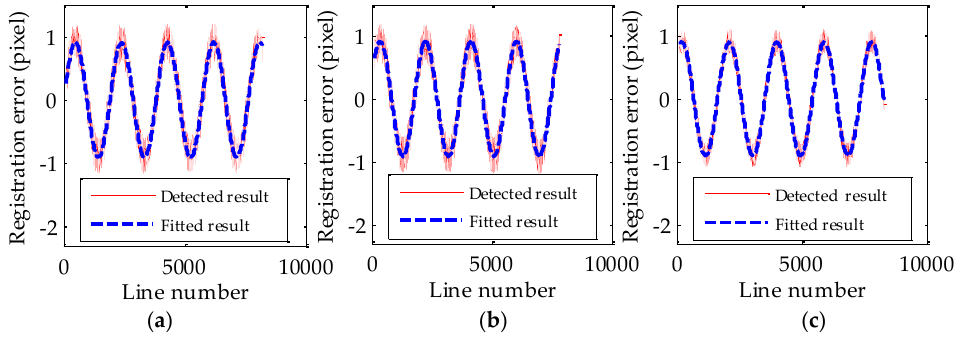
Figure 6. The absolute registration error curves of different bands ( a ) B1; ( b ) B2; ( c ) B3. Table 5. The comparison of parameters of jitter displacement for multispectral images of ZY-3.